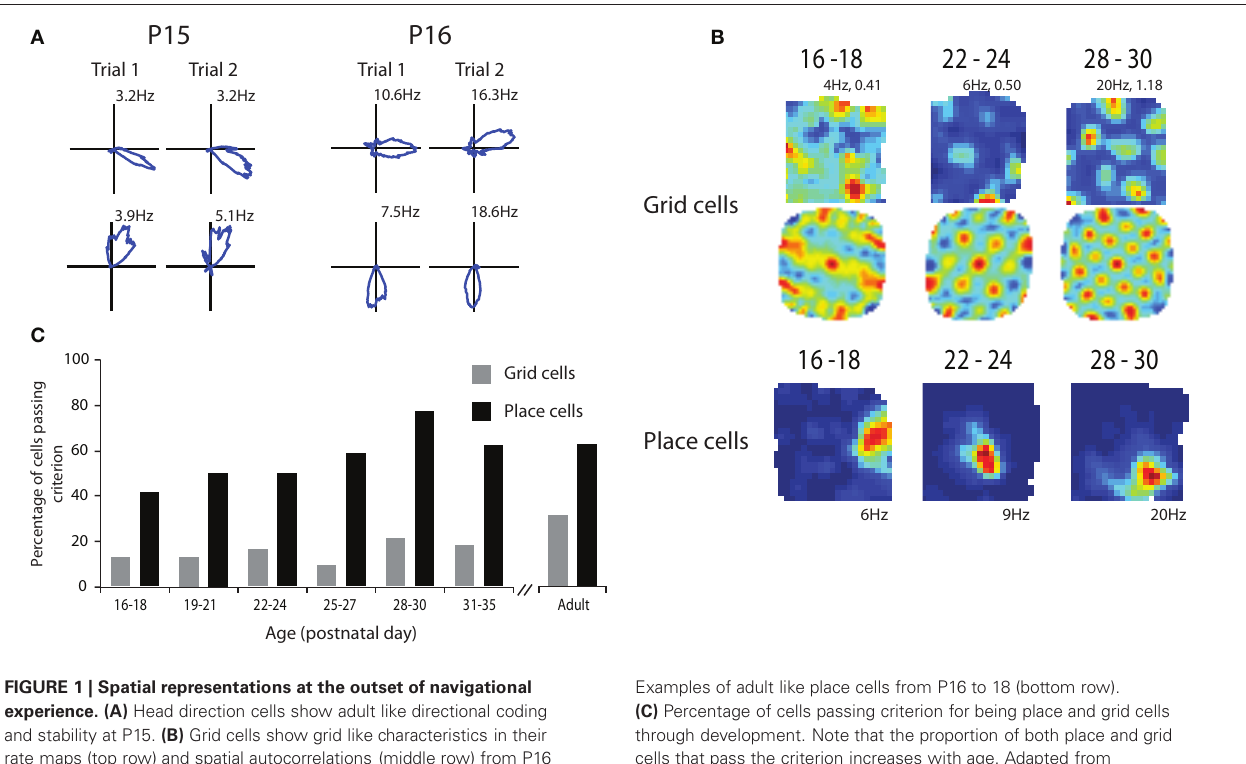
FIGURE 1 | Spatial representations at the outset of navigational experience. (A) Head direction cells show adult like directional coding and stability at P15. (B) Grid cells show grid like characteristics in their rate maps (top row) and spatial autocorrelations (middle row) from P16 to 18 but the regularity and specificity of the grid increases with age.